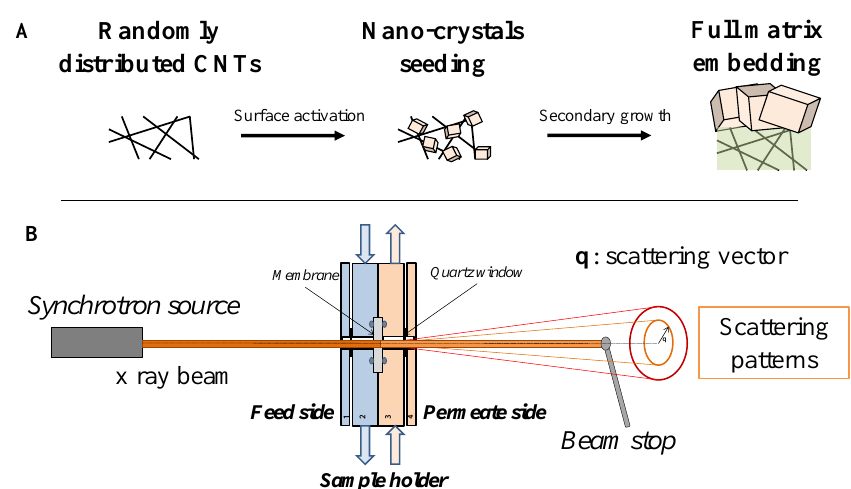
Figure A1. ( A ) Schematic of the MOF-CNT membranes fabrication and structure including (i) formation of a CNT BP by filtration of suspended CNTs; (ii) surface adsorption of Zn 2+ for activation and (iii) full growth ZiF-8 crystals between the CNTs and across the BP thickness by the secondary growth method and ( B ) schematic of the SAXS acquisition process across the gas cross flow permeation module and corresponding scattering patterns formation.